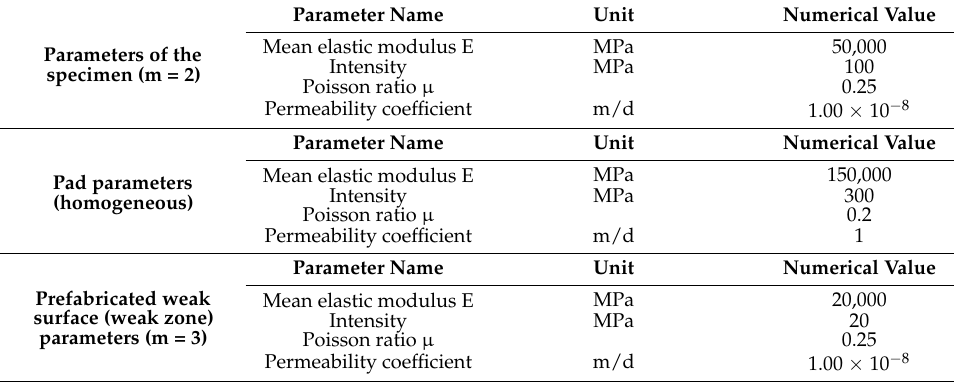
Table 1. Sample mechanical properties (average